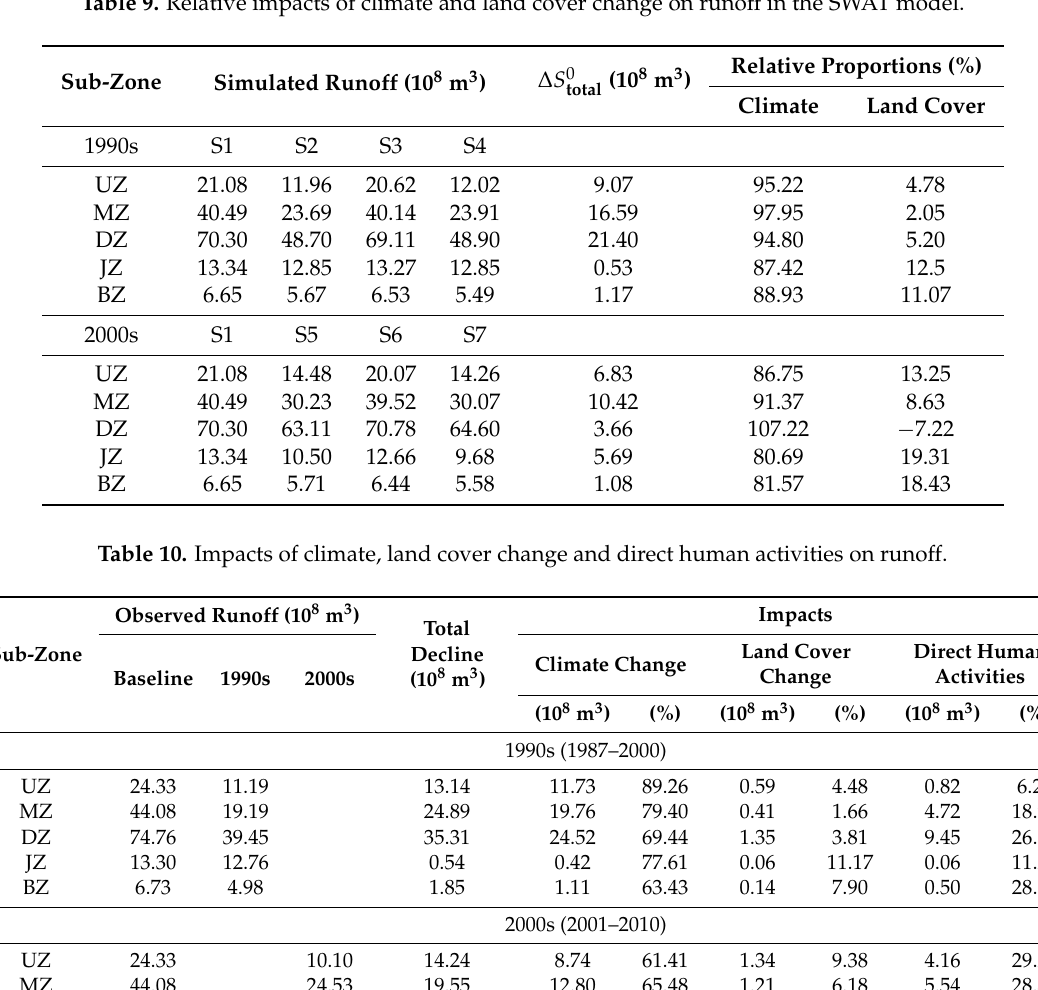
Table 9. Relative impacts of climate and land cover change on runoff in the SWAT model.